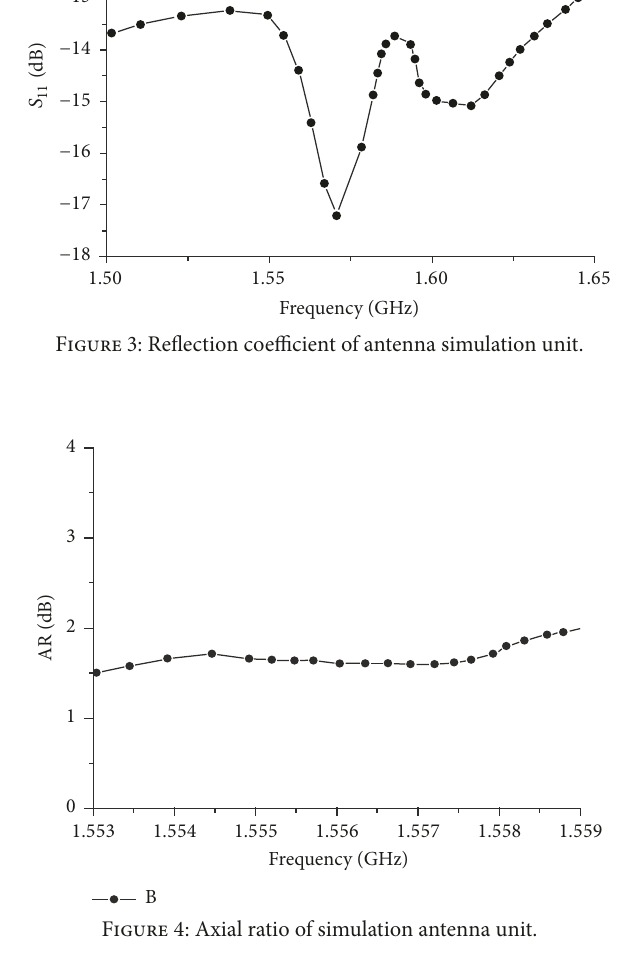
Figure 5: Series and parallel schematics of 10-element array.